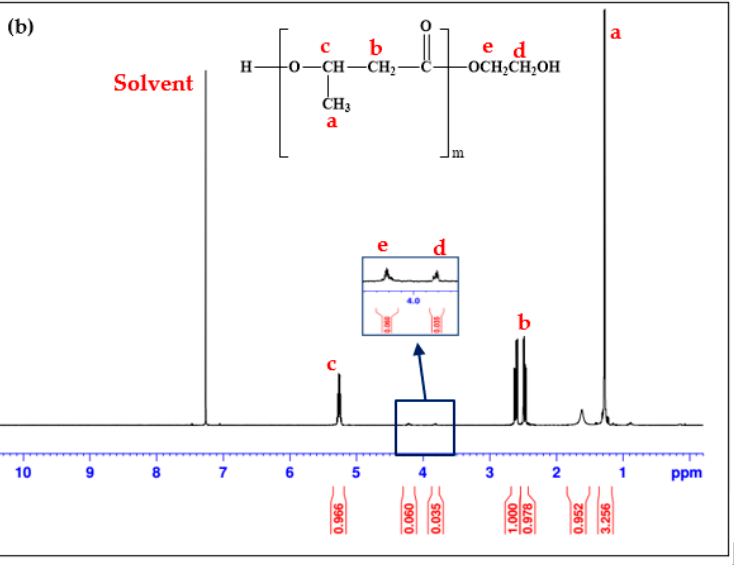
Figure 2. NMR spectra of ( a ) PHB and ( b ) PHBD 8h.